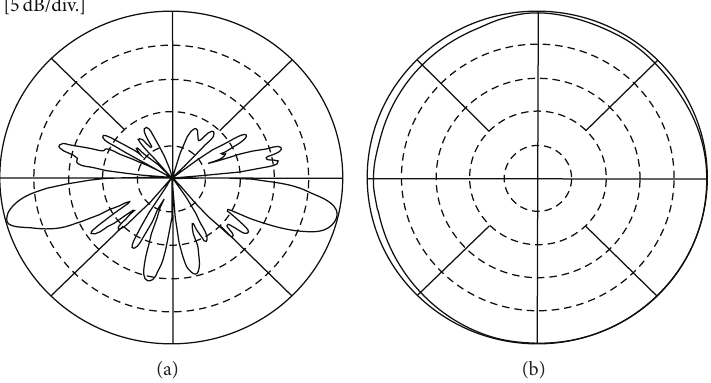
Figure 7: Measured radiation patterns of collinear antenna with beam tilt (V tilt antennas). (a) Vertical plane. (b) Conical plane.